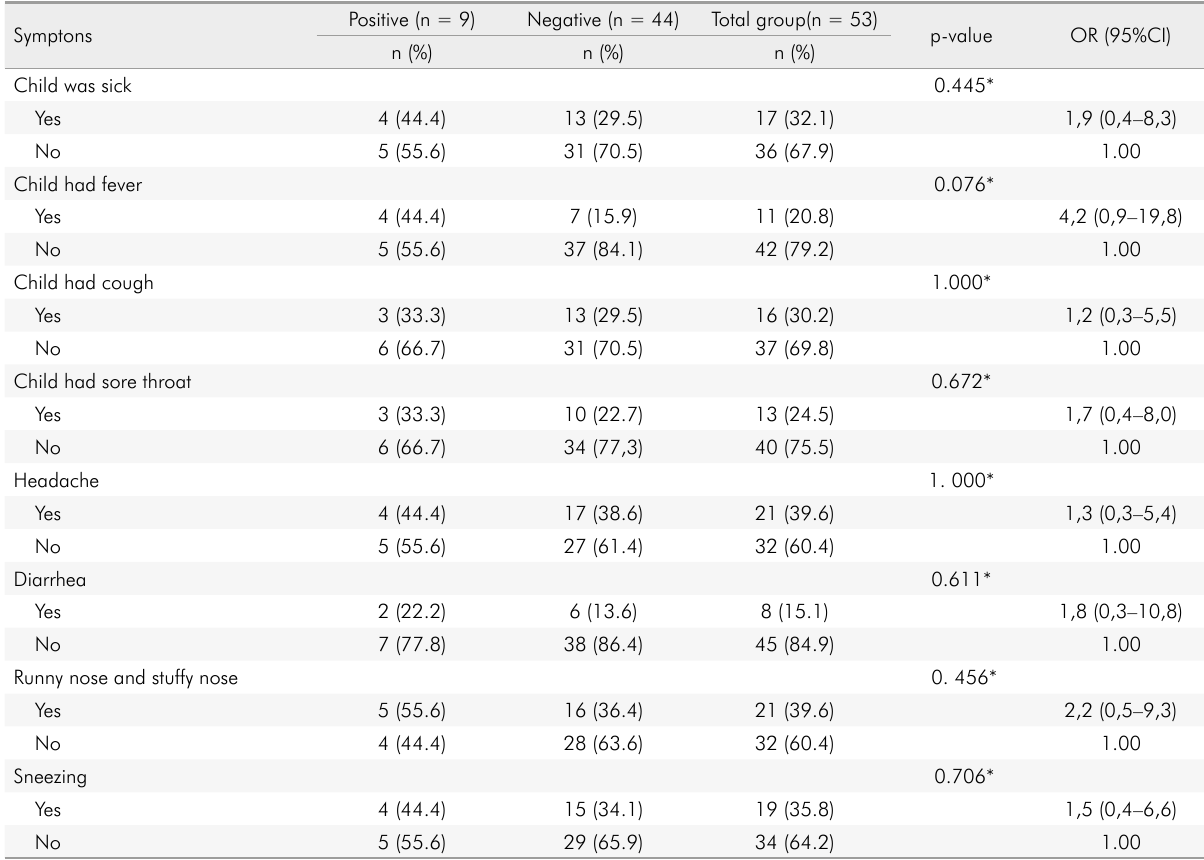
Table 3. Most frequent signs and symptoms and serological test for COVID-19